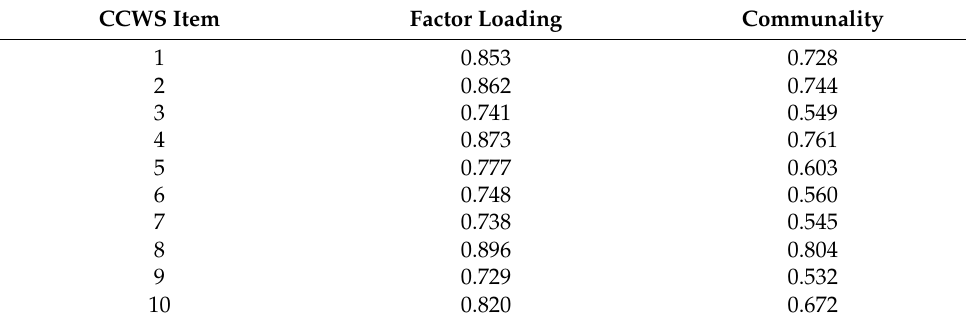
Table 3. Item factor loadings and